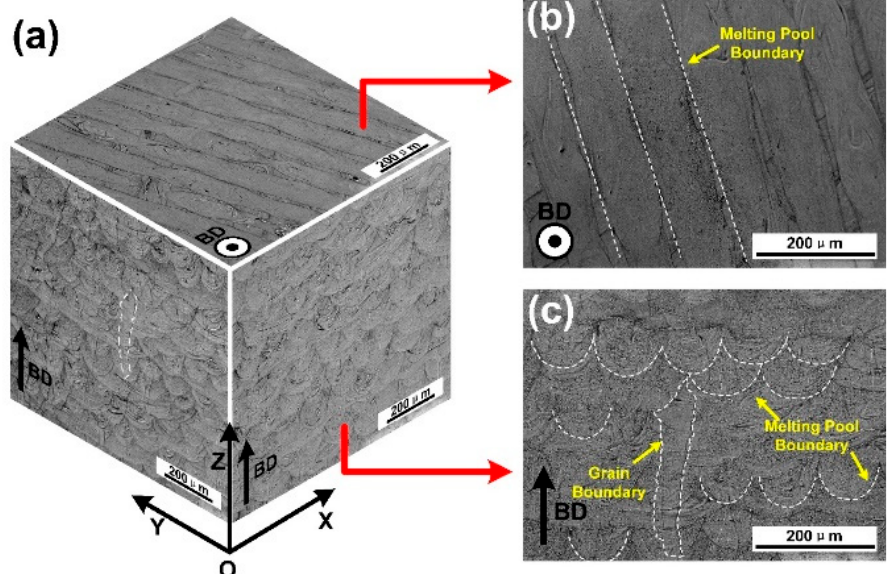
Figure 3. Microstructure demonstration of three-dimensional ( a ), XOY ( b ) and XOZ ( c ) planes of SLM produced CoCrFeMnNi high-entropy alloy taken by optical microscope (BD represents building direction).